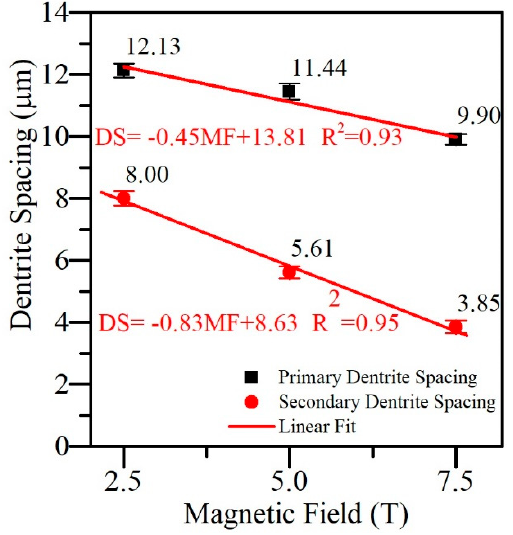
Figure 6. Variations in the external magnetic field versus the primary and secondary dendritic spacing.